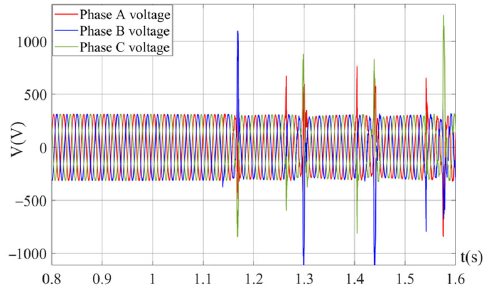
Figure 15. Three ‐ phase voltages of AC bus (Group B). Figure 15. Three-phase voltages of AC bus (Group